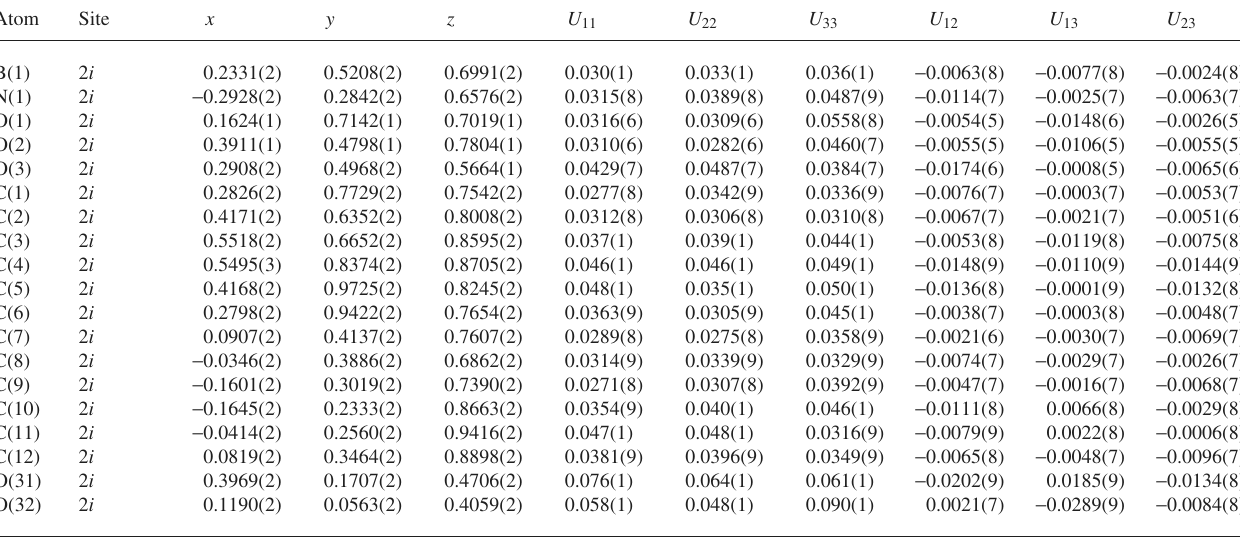
Table 3. Atomic coordinates and displacement parameters (in Å 2 ) .